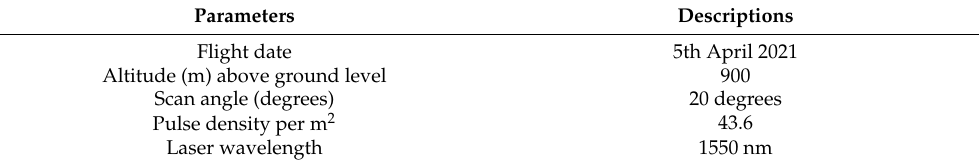
Table 1. Technical specification for the airborne laser scanning sensor and